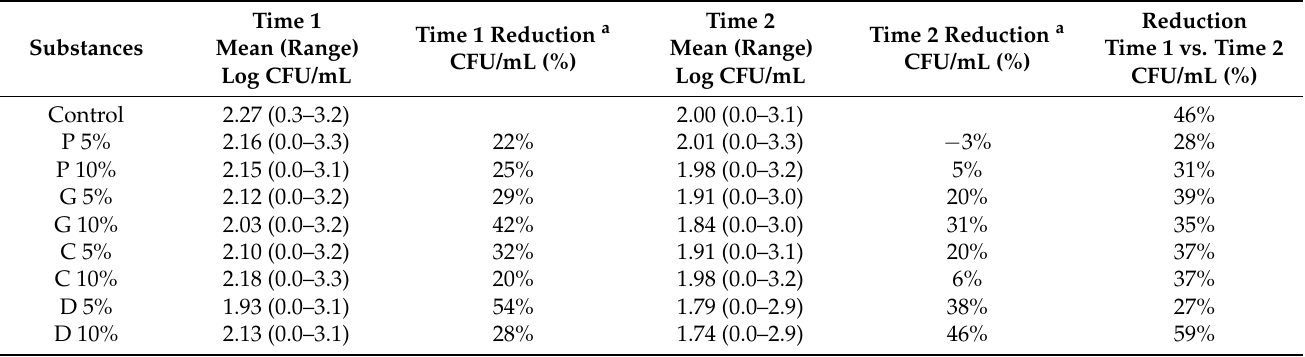
Table 5. Number of bacteria (CFU/mL) in the semen before (control) and after exposure of different substances at Time 1 and Time 2 at 5 ◦